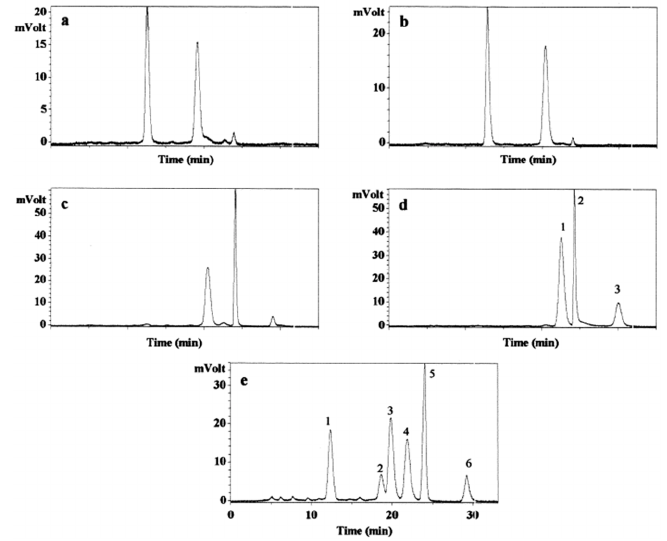
Figure 3. ( a – e ) Chromatogram of chiral separation of E / Z- α -tocotrienol methyl ether by Chiralcel